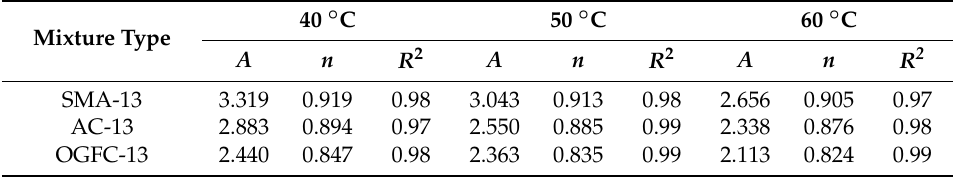
Table 4. Parameters of the triaxial strength model of asphalt mixtures.